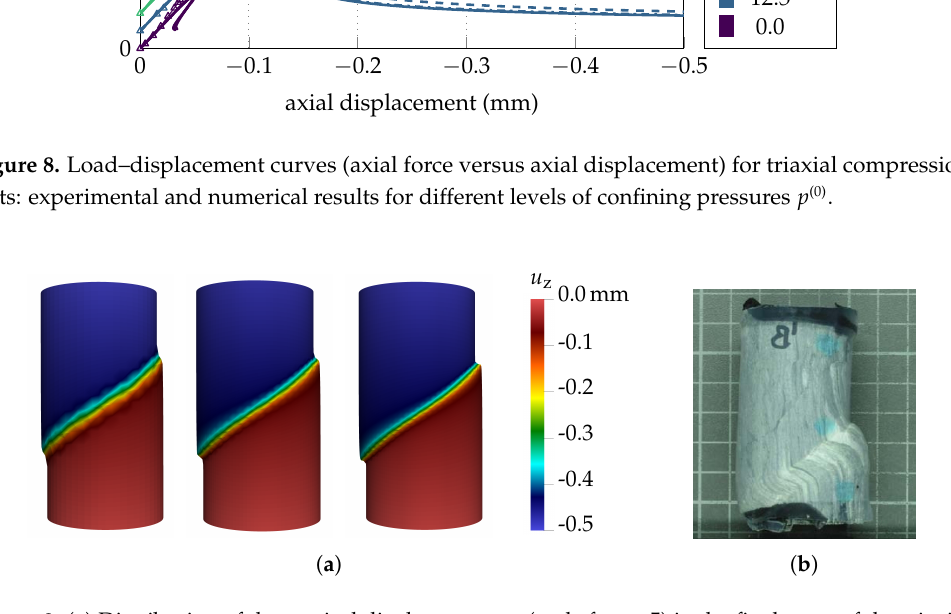
Figure 9. ( a ) Distribution of the vertical displacement u z (scale factor 5) in the final stage of the triaxial compression test with p (0) = 37.5MPa for the three finite element meshes: coarse ( left ), medium ( center ), and fine ( right ). ( b ) Corresponding deformed rock specimen after a triaxial compression test with p (0) = 37.5MPa, reproduced with permission from M. Bluemel taken from the report [41].